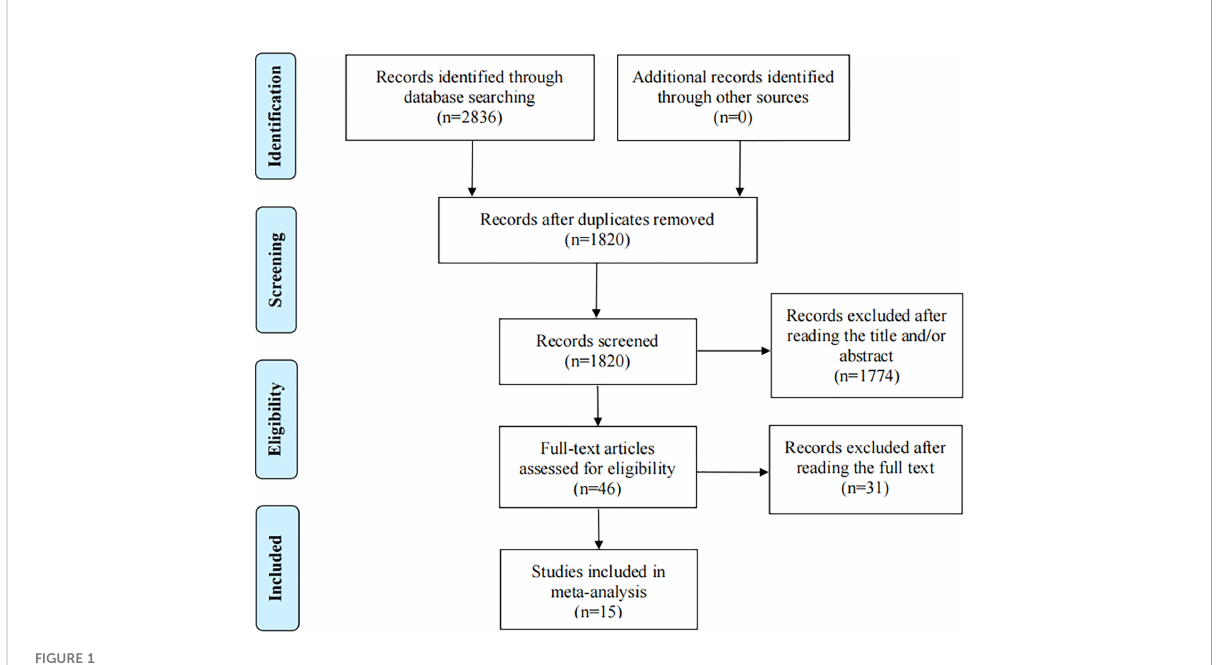
FIGURE 1 Flow diagram of the process of selection of